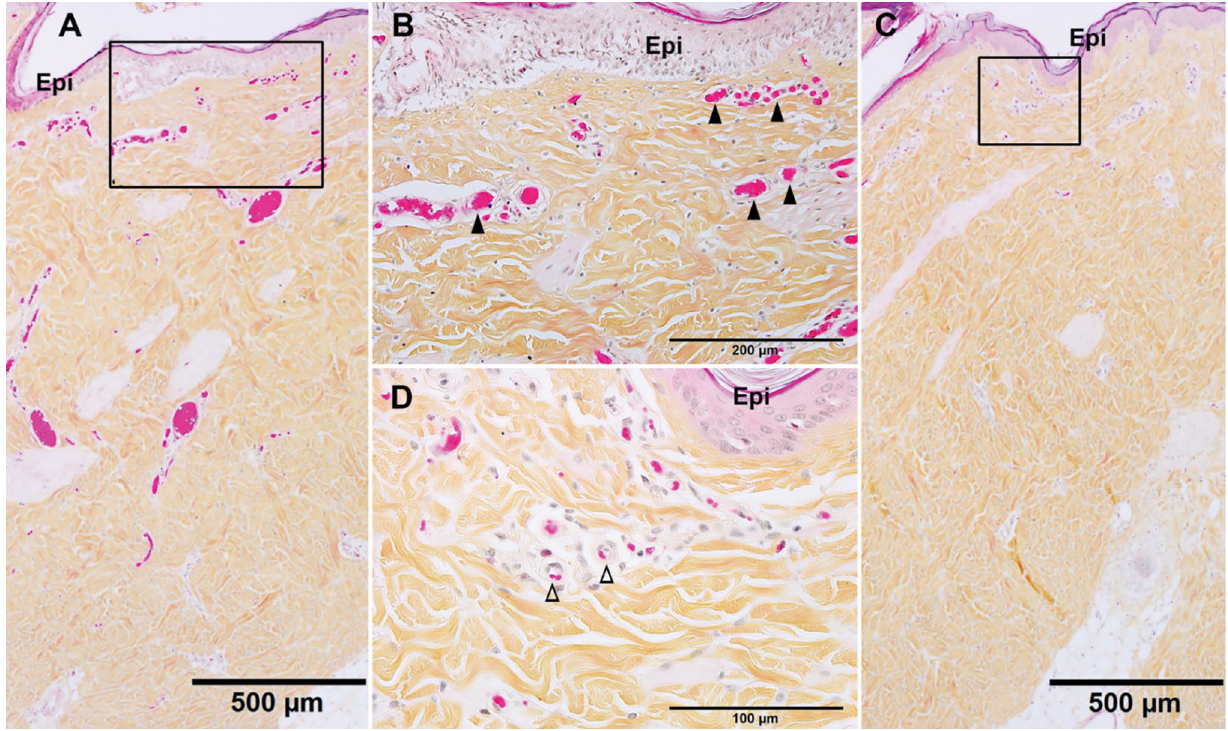
Figure 1. Representative HPS micrographs of burn site ( A,B ) and interspace ( C,D ) of a porcine burn wound 30 min after burn. ( B ) and ( D ) are higher power of the boxes in A and C, respectively. ▲ , blocked small vessels beneath the epidermis. ∆, Clear vessels beneath the epidermis of interspace. Bar = 500 µm ( A,C ), 200 µm ( B ), 100 µm ( D